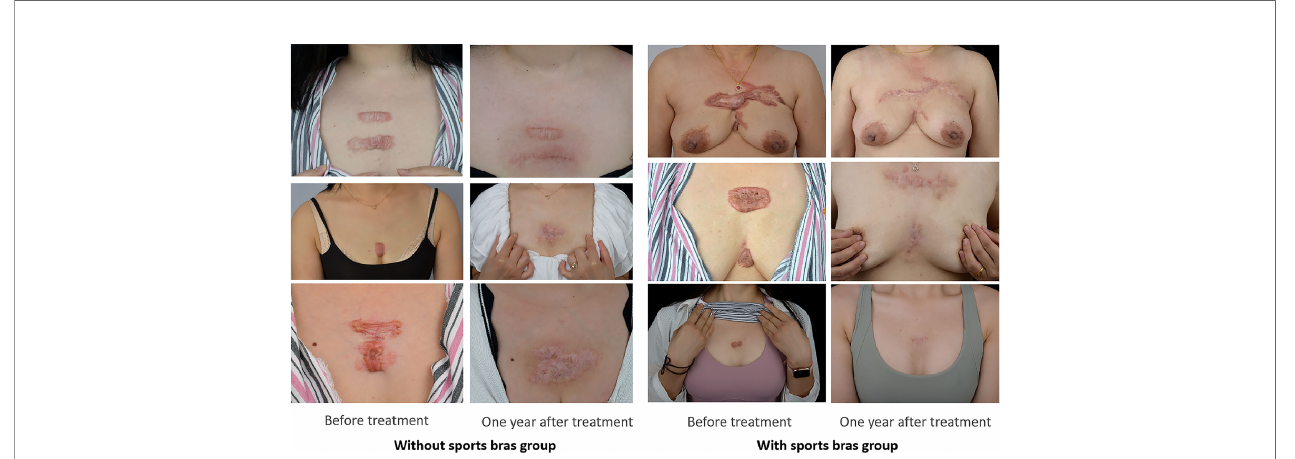
FIGURE 1 | The clinical pictures of patients in both groups before and one year after operation. The patients in sports bra group exhibit milder erythema and telangiectasia and smaller vertical width of lesion one year after treatment compared to patients in no sports bra